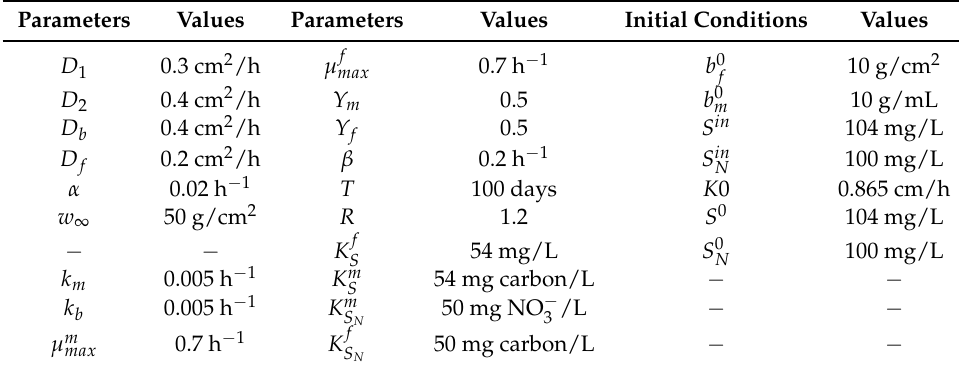
Table 1. Model parameter values used for the